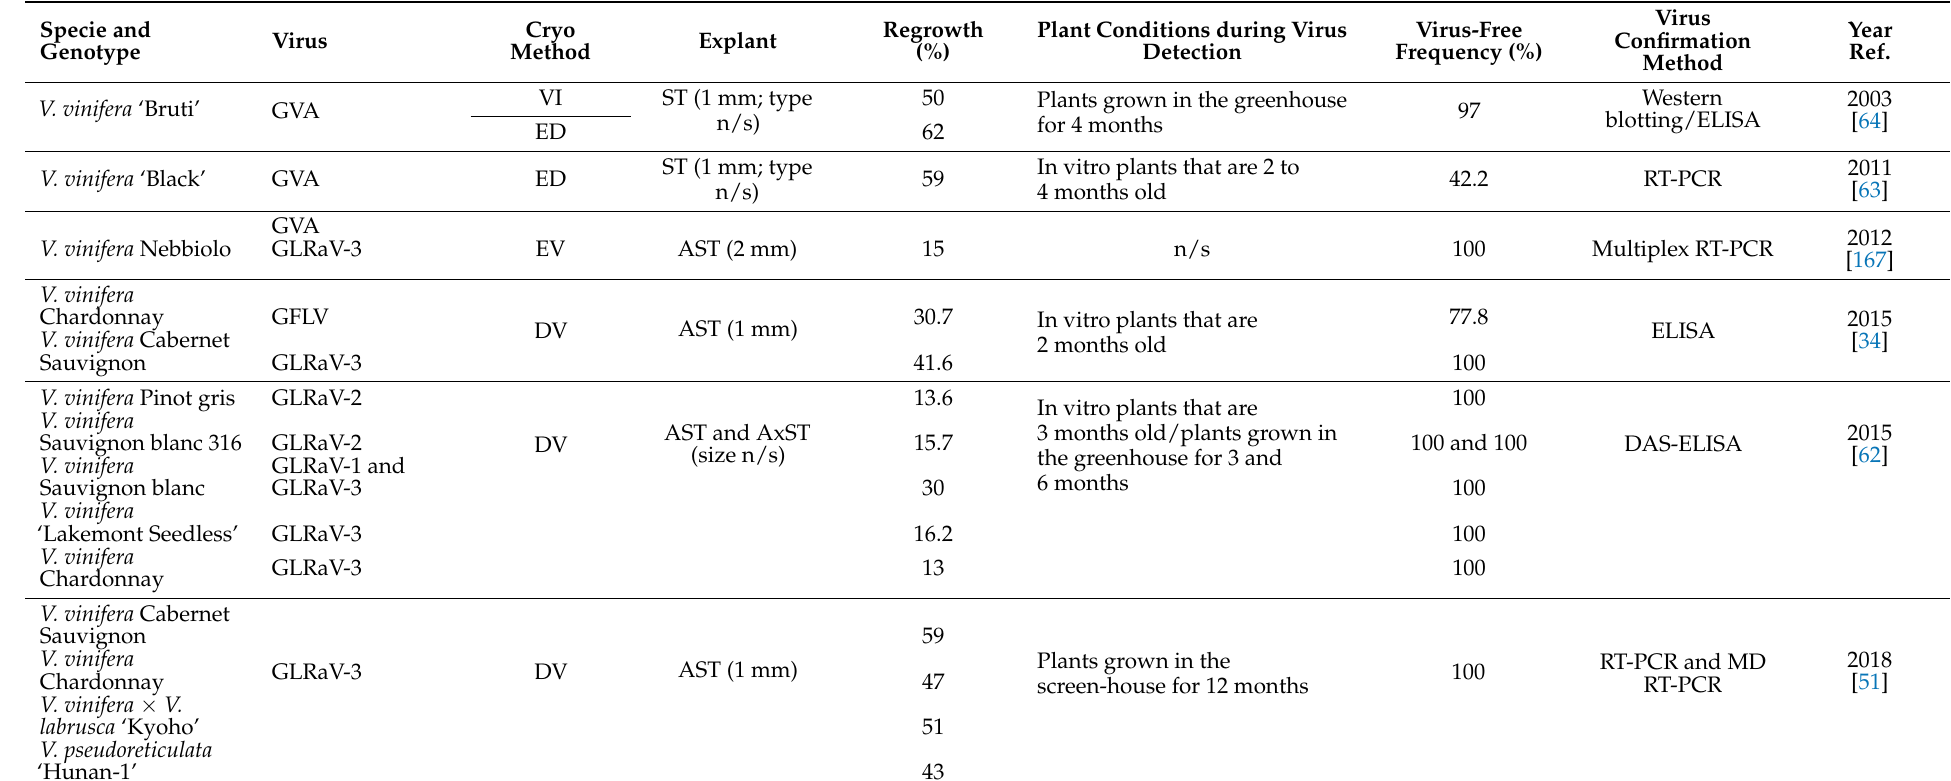
Table 2. Shoot tip cryotherapy for eradication of grapevine ( Vitis spp.)